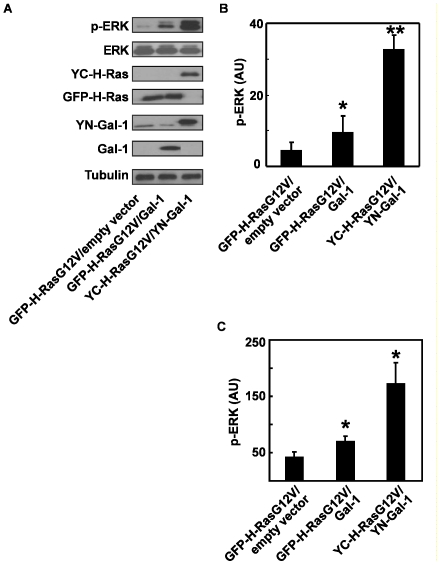
Enhanced activation of ERK by YC-H-RasG12ṼYN-Gal-1 complexes.HEK 293 or BHK cells were co-transfected with GFP-H-RasG12V/empty vector, GFP-H-RasG12V/Gal-1 or YC-H-RasG12V/YN-Gal-1 and lysed 48 h later. Aliquots of the cell lysates were subjected to SDS-PAGE followed by immunoblotting with anti-phospho-ERK, anti-ERK, anti-pan-Ras, anti-Gal-1 and anti-tubulin (loading control) antibodies. Typical immunoblots representing one of four experiments performed with HEK 293 cell are shown in panel A and quantitative densitometry of the levels of phospho-ERK (arbitrary units, means ± SEM, n = 4) are shown in panel B. *P<0.05, GFP-H-RasG12V/Gal-1 vs. GFP-H-RasG12V/empty vector; **P<0.0001, YC-H-RasG12V/YN-Gal-1 vs. GFP-H-RasG12V/Gal-1. Results obtained with BHK cells (arbitrary units, mean ± SEM, n = 2, *P<0.05) are shown in panel C.